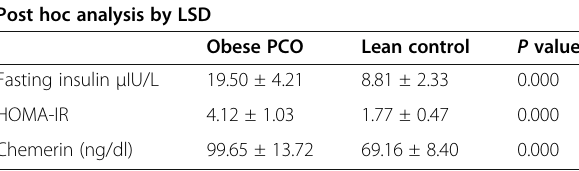
Table 3 Post hoc analysis (Obese PCO and lean control) as regards fasting insulin, HOMA-IR, and chemerin Post hoc analysis by LSD